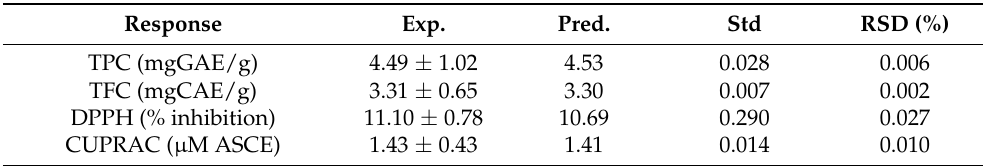
Table 4. Experiment data of the validation of predicted values at optimal extraction conditions of